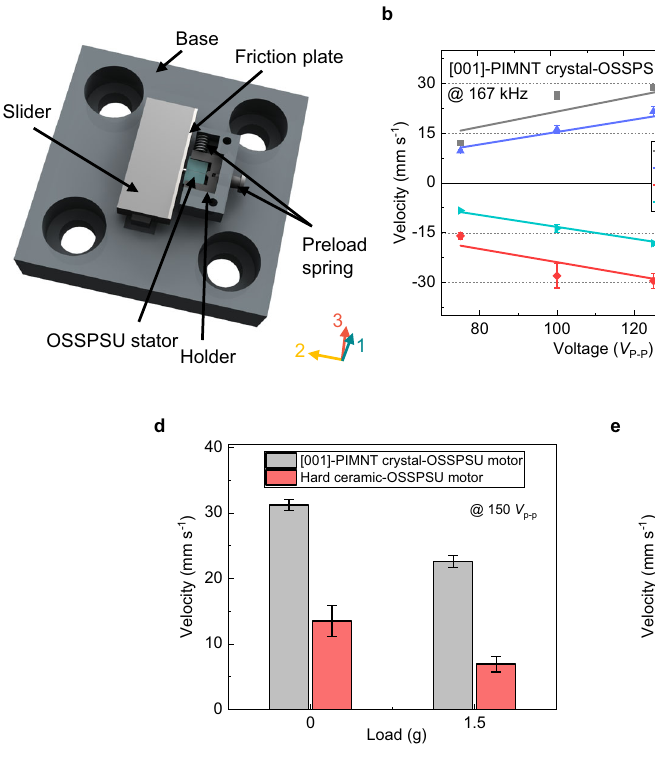
velocity performance for [001]-PIMNT crystal and hard ceramic-OSSPSU motors under the same conditions. e Plot of the velocities of [001]-PIMNT crystal-OSSPSU motor (at 150 V P-P ) and hard ceramic-OSSPSU motor (at 250 V P-P ) versus the load. Theerrorbarsin b , c ,and e representthestandarddeviationsofthevaluesofeach motor measured three times under the same